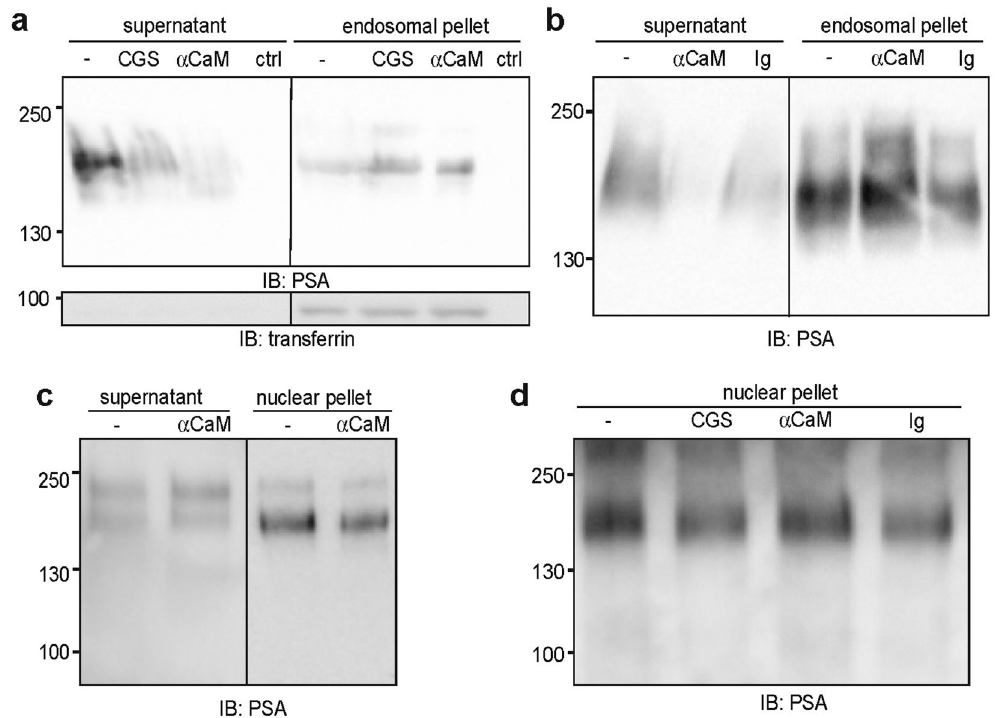
Figure 3. The release of the PSA-carrying NCAM fragment from endosomes is mediated by calmodulin, while the nuclear import is not mediated by calmodulin. ( a , b ) A cytoplasmic fraction was isolated from untreated PSA-deficient CHO cells and an endosome-enriched fraction was isolated from PSA-expressing CHO cells after cell surface biotinylation and treatment with NCAM antibody. The cytoplasmic fraction was incubated with buffer (ctrl) or with the endosomal fraction in the absence ( − ) or presence of 10 µ M calmodulin inhibitor CGS9343B (CGS), 8 µ g/ml calmodulin antibody ( α CaM) or 8 µ g/ml of a non-immune control antibody (Ig). After ultracentrifugation, biotinylated proteins were isolated from the resulting pellets and supernatants and subjected to immunoblot analysis with the PSA antibody. Before isolation of biotinylated proteins, aliquots of the pellets and supernatants were subjected to immunoblot analysis with transferrin antibody to check for integrity of endosomes. ( c , d ) Nuclei were isolated from NCAM-deficient cerebellar neurons and a cytoplasmic fraction was isolated from wild-type cerebellar neurons after treatment with chicken NCAM antibody (12.5 µ g/ml IgY). Nuclei were incubated with buffer (ctrl) or with the cytoplasmic fraction in the absence or presence of 10 µ M calmodulin inhibitor CGS9343B (CGS) or 8 µ g/ml calmodulin antibody ( α CaM) or 8 µ g/ ml control antibody (Ig) followed by centrifugation at 1,000 × g. The pellets and supernatants were subjected to immunoblot analysis with the PSA antibody. ( a – d ) Representative immunoblots out of two independent experiments are shown. Lanes that were not adjacent to each other but derived from the same blot are indicated by dividing